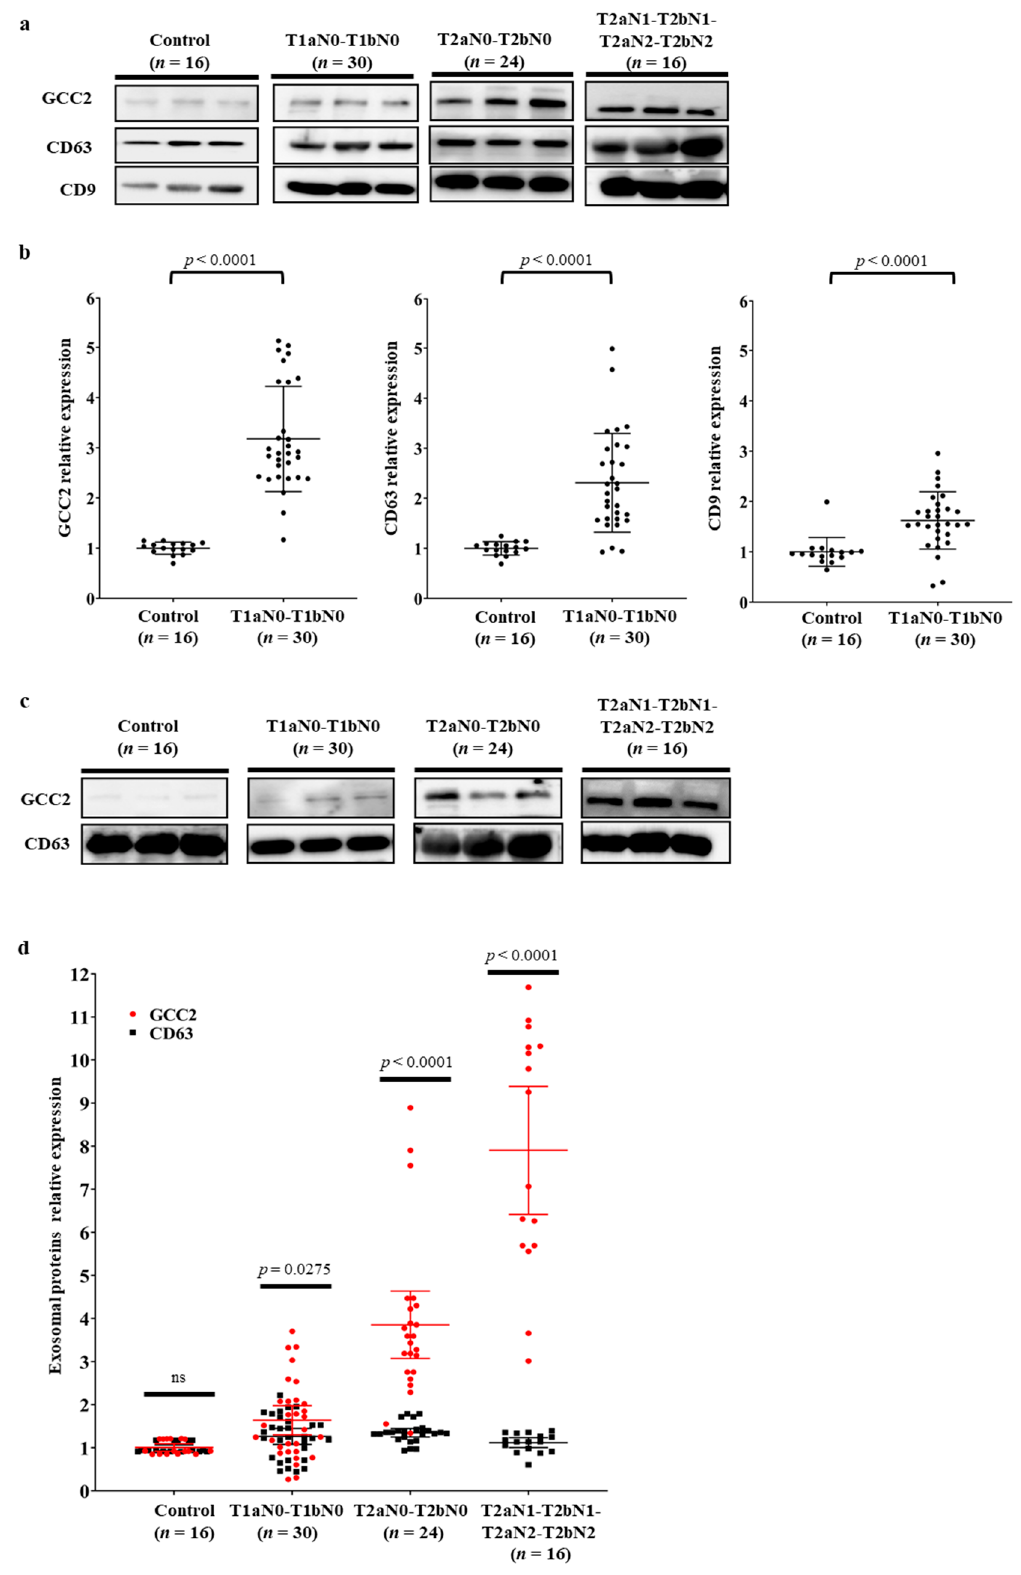
Figure 3. GCC2 levels in NSCLC patient plasma-derived exosomes. ( a ) Comparison of GCC2, CD63, and CD9 protein levels in the plasma-derived exosomes isolated from the healthy control group ( n = 16) and patients suffering from different pathological stages of NSCLC ( n = 70) by western blot analysis. Each of the three lanes represents 3 healthy controls and 3 patients at different pathological stages of NSCLC. ( b ) Comparison of the relative intensities of GCC2, CD63, and CD9 protein levels between the control and T1aN0-T1bN0 patient groups ( n = 30). Protein intensities were measured using